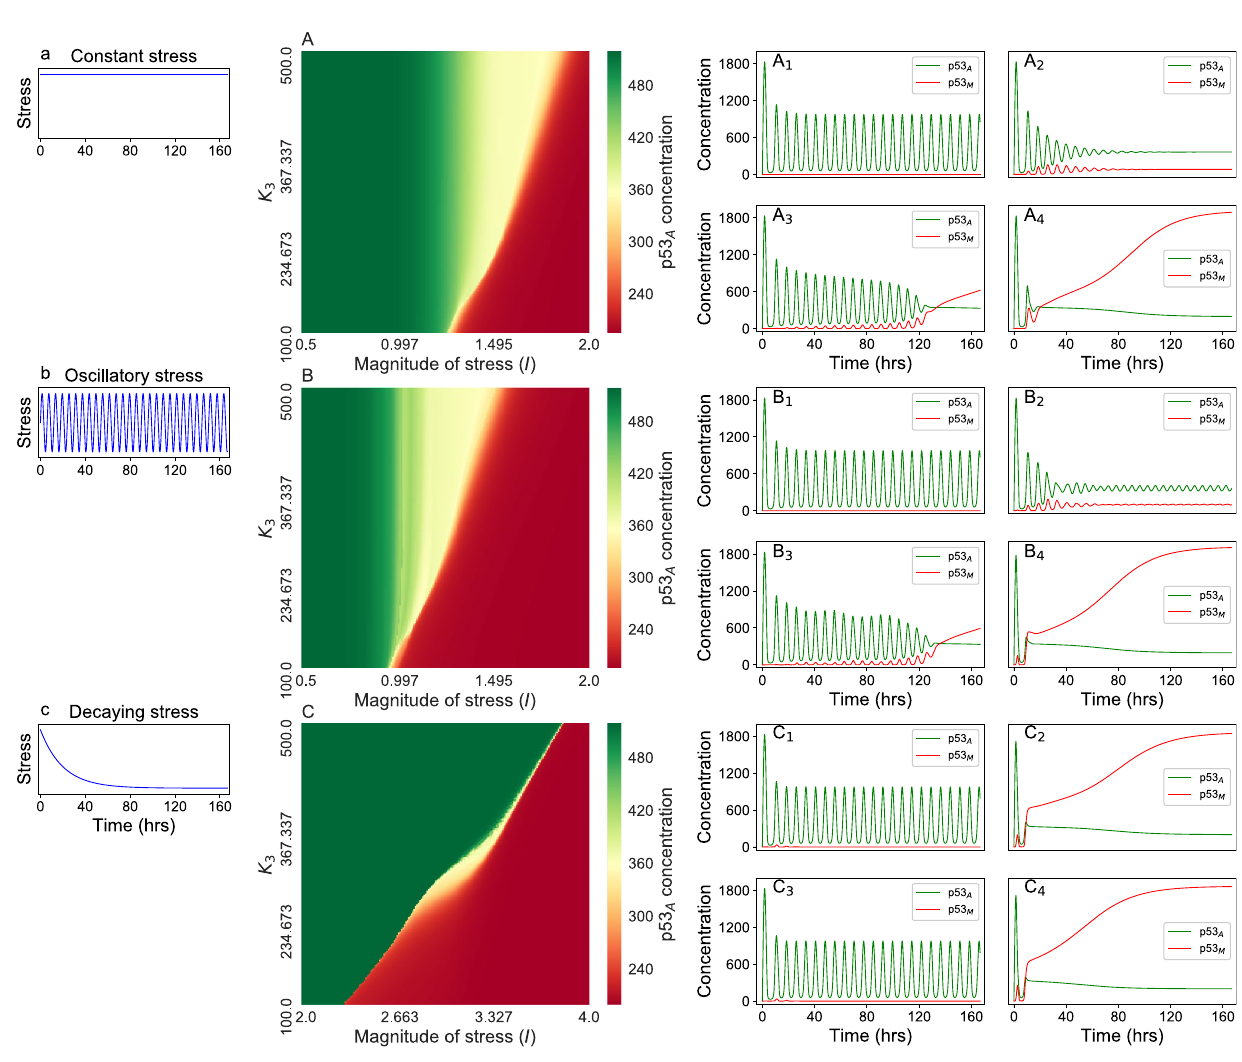
Figure 6. The left column show three different form of stress discussed about. Second column ( A – C ) show two parameter steady state behavior of the system for three different form of driven stress ( a – c ) respectively. A 1 , A 2 , A 3 , and A 4 correspond to the time course of p53 p53 A (green), and M (red) for the parameter set (0.5,500.0), (1.6, 500.0), (1.27, 100.0), and (2.0, 200.0) respectively on the heat map A. B 1 , B 2 , B 3 , and B 4 correspond to the time course for the parameter set (0.5,500.0), (1.3, 500.0), (0.96, 100.0), and (2.0, 200.0) respectively on the heat map B. And C 1 , C 2 , C 3 , and C 4 for the parameter set (2.0,500.0), (4.0, 500.0), (2.0, 100.0), and (4.0, 100.0) respectively on the heat map C. First, and second term in the parameter set correspond to magnitude of stress ( I ), and K 3 respectively. Green, yellow, and red region indicate active, apoptotic, and cancer phase respectively on the heap map ( A – C phase. A similar scenario has been observed in the case of oscillatory and decaying phase. Figure 5B,C shows irreversibility from cancer phase to apoptotic and recovery phase, respectively, as observed in the real picture of cancer. Similar scenario was observed transition between recovery and apoptotic state where, stress in forwarding direction moves recovery state into apoptotic phase whereas, backward stress does not move apoptotic phase into recovery phase, which shows irreversible transition from apoptotic phase to the recovery phase. Phase transition and key to therapeutic intervention. In this section, we study the dynamical behavior of p53 A , and p53 M in two-parameter space driven by different stress (Fig. 6A). Each point in two-parameter space ( Mag- nitude of stress , K 3 ) (Fig. 6A) is calculated concentrations of p 53 A in the dynamics: for oscillatory dynamics each point is the average of maxima and minima obtained in the time interval [145.82, 166.66] h, otherwise (no oscillation) concentration are measured at time 166.66 h. Figure 6 A (with constant stress) shows three distinct regimes/phases active (green region), apoptosis (yellow region) and cancer (red region). For large value of K 3 , transition from active to cancer state is through apoptotic phase, while for low value of K 3 , the range of apoptotic regime is so thin that slight increase in stress magnitude ( I ) might lead to direct cancer phase. Transition from active to apoptotic state is one directional. Figure 6 A 1 , A 2 , A 3 , and A 4 are the time course at different point on the heat map (Fig. 6A).